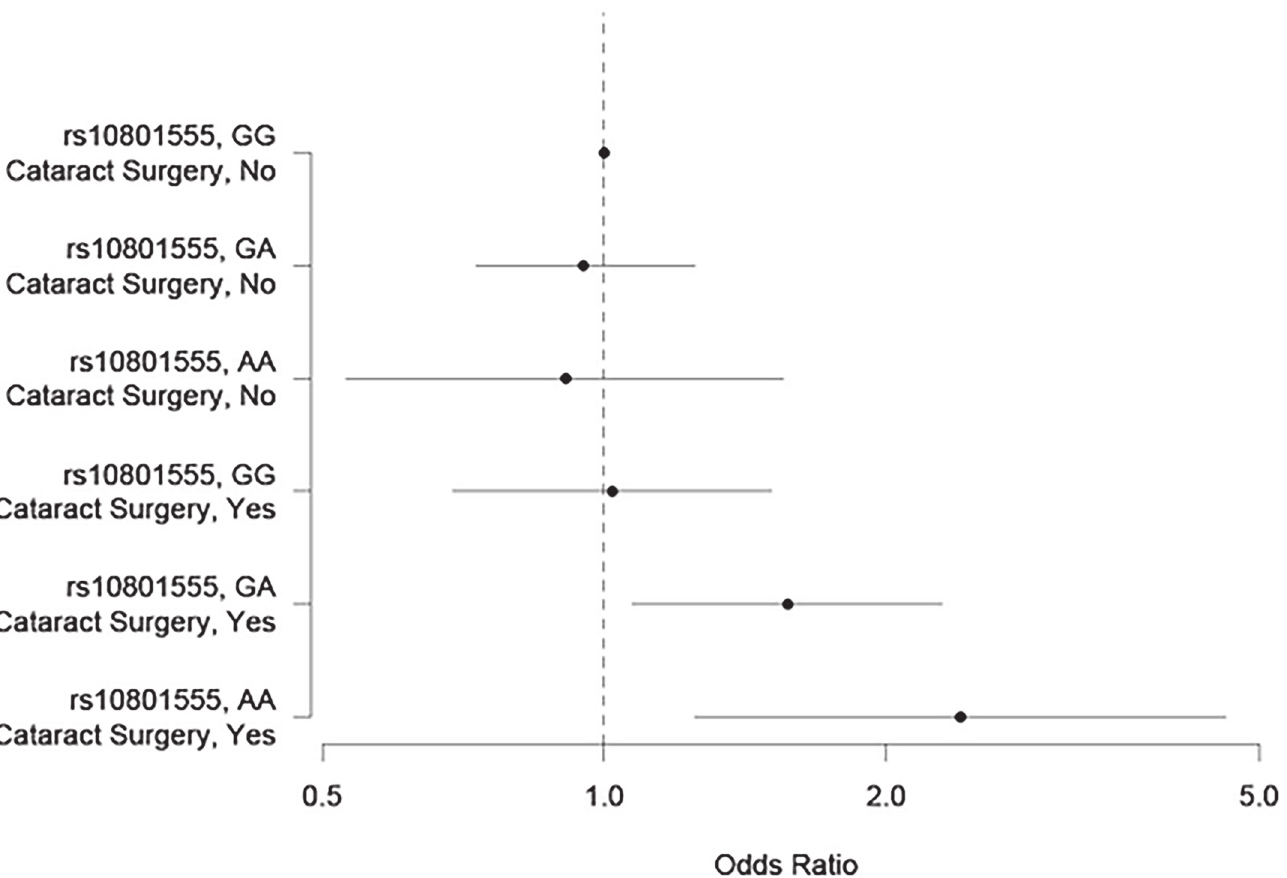
Fig 1. Forest plot of joint effects of pseudophakic\aphakic status and CFH SNP on risk of early